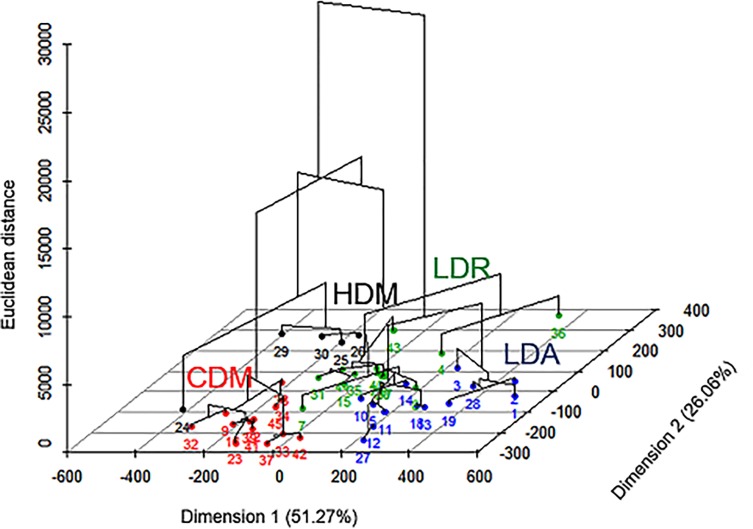
Representation of the types of our typology in a Cartesian plane made with the first two axes of the principal components analysis.The 4 types were: complex diversified multistrata (CDM), low diversity with regular trees (LDR), low diversity with clustered trees (LDC), and high density of Musaceae (HDM).